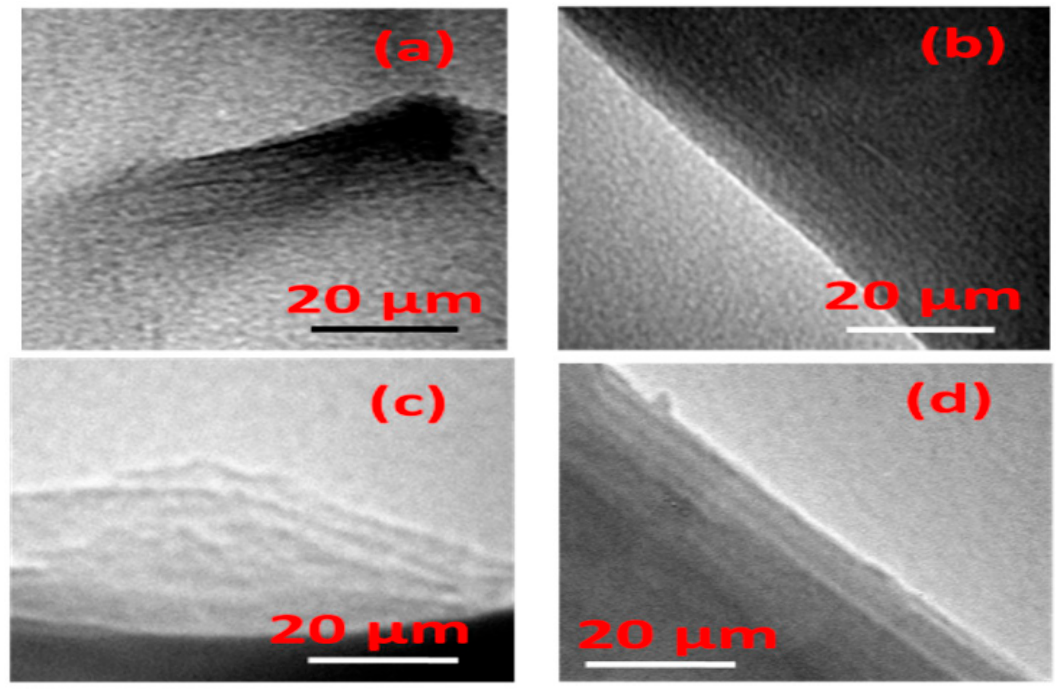
Figure 3. TEM micrographs of ( a ) Ca-Mt ( b ) after intercalation with Zr species (Zr-Mt). ( c ) Al-PCH and ( d ) Zr-PCH materials after calcination at 550 ◦